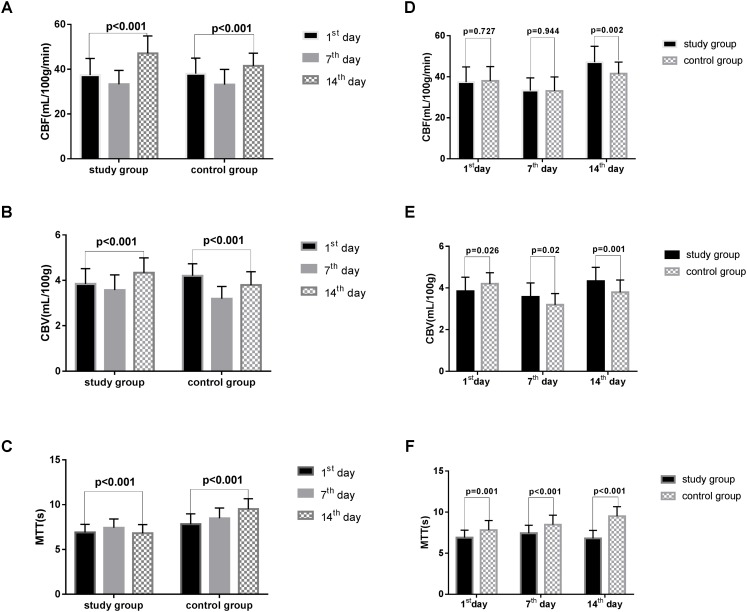
The CBF, CBV, MTT in two groups. CBF, cerebral blood flow; CBV, cerebral blood volume; MTT, mean transit time. All the data were analyzed using student’s t-test. (A) CBF variations in the two groups based on time after surgery. (B) The variation in CBV in the two groups based on time after surgery. (C) The variation in the MTT of the two groups based on time after surgery. (D) The difference in CBF in two groups on the 1st, 7th, and 14th day after surgery. (E) The difference in CBV in the two groups on the 1st, 7th, and 14th day after surgery. (F) The difference in MTT in the two groups on the 1st, 7th, and 14th day after surgery.